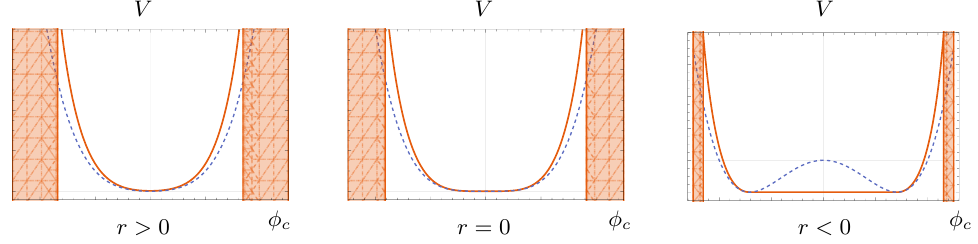
Figure 3 . Effective potential in five dimensions: unbroken ( r > 0 ), critical ( r = 0 ) and broken phase ( r < 0 ). The dotted lines represent the tree-level potential, the red lines represent the effective potential that is always convex. In the shaded region the effective potential is infinite, signaling the breakdown of the effective field theory (eft) which requires a uv